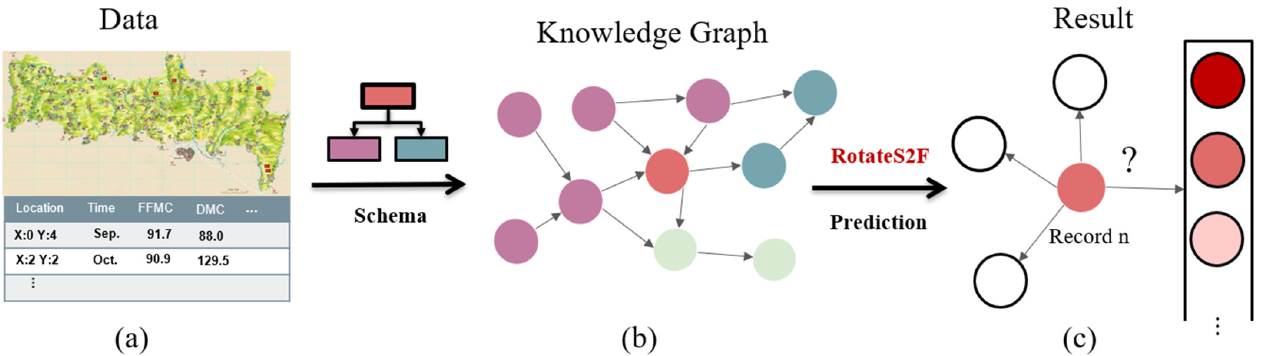
Figure 1. Concept of the paper. ( a ) Discretization forest fire data and constructing a knowledge graph by schema. ( b ) Different colored nodes indicate different kinds of data. Semantic and structural features are extracted by RotateS2F. ( c ) Prediction of forest fire burning areas by link prediction algorithm on the knowledge graph. A darker color indicates a higher probability of matching Record n.